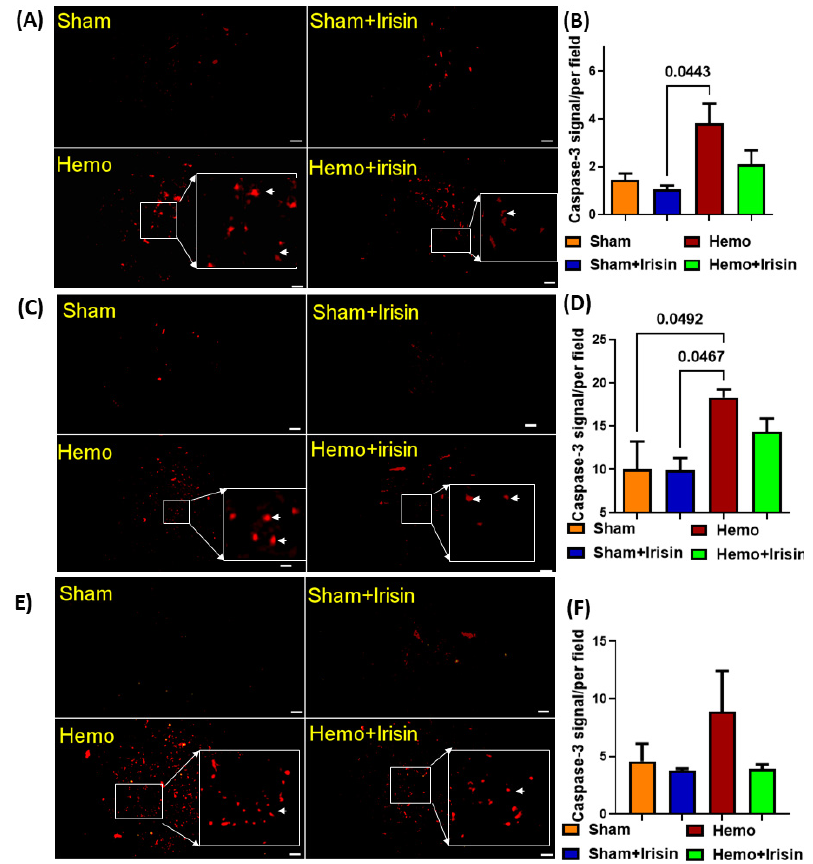
Figure 6. Immunostaining of active caspase-3 signals in the skeletal muscle and cardiac muscle. ( A )